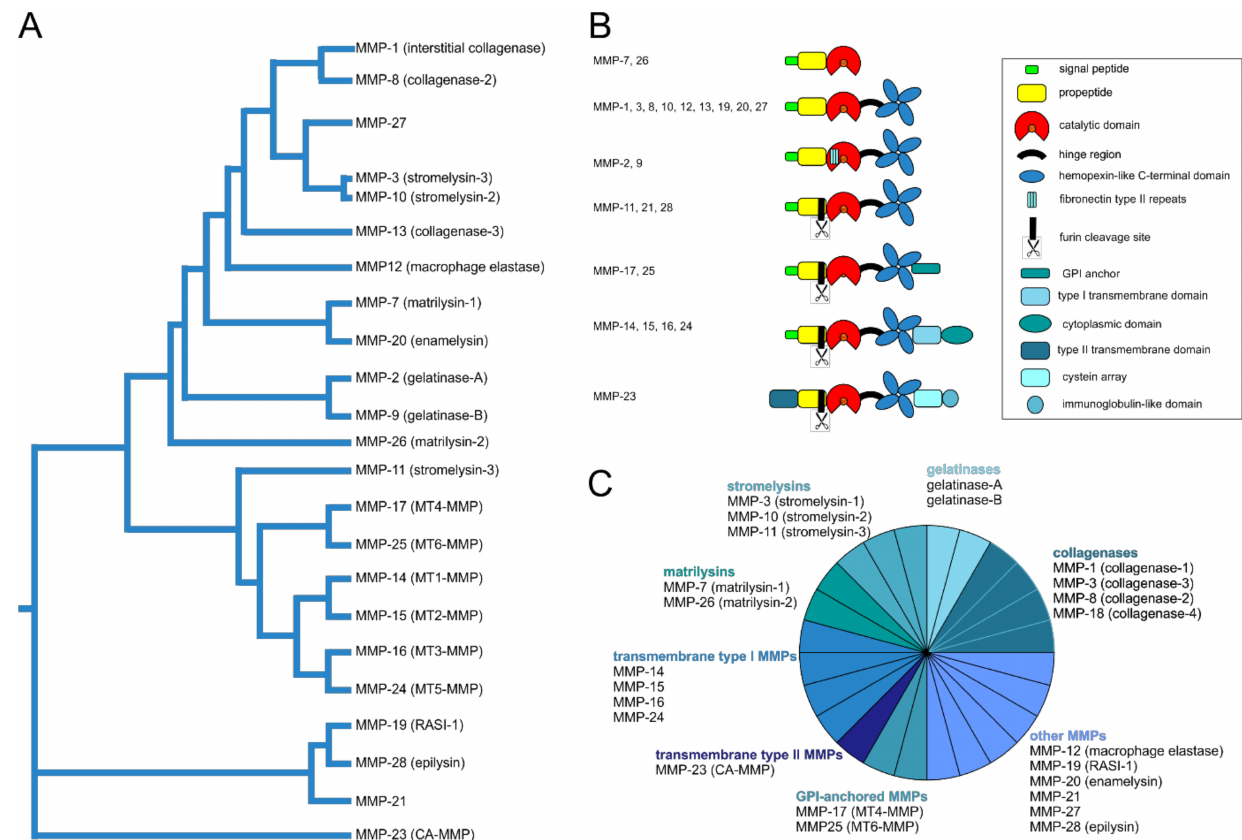
Figure 3. Phylogenetic and functional relationship of human matrix metalloproteinases (MMPs). In addition to the numbering of the MMPs, which corresponds to the order of their discovery, the MMPs can be ordered according to their sequence similarity [154,155] (A) . Regarding their domain organization (B) and substrate specificity they can be assigned to different groups within the MMP family ( C ): soluble collagenases, gelatinases, stromelysins, matrilysins, membrane- anchored transmembrane type I and type II as well as glycosylphosphatidylinositol (GPI)-anchored MMPs, and other MMPs [152]. All MMPs except MMP-23 have a propeptide with an N-terminal signal sequence. To activate an MMP, this propeptide has to be cleaved off in order to make a zinc ion in the active site of the catalytic domain, which also holds calcium ions, accessible through a cysteine switch. CA-MMP, cysteine array matrix metalloproteinase; RASI-1, rheumatoid arthritis synovium